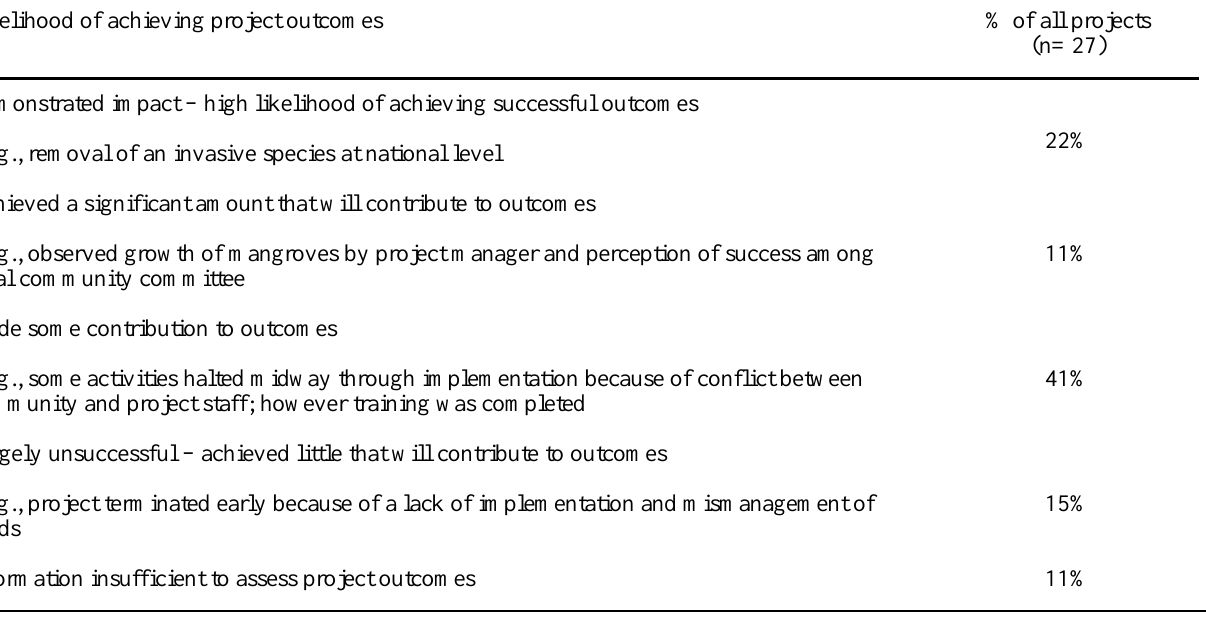
Table 1. Estimated effectiveness of conservation projects in Samoa based on the likelihood of achieving stated